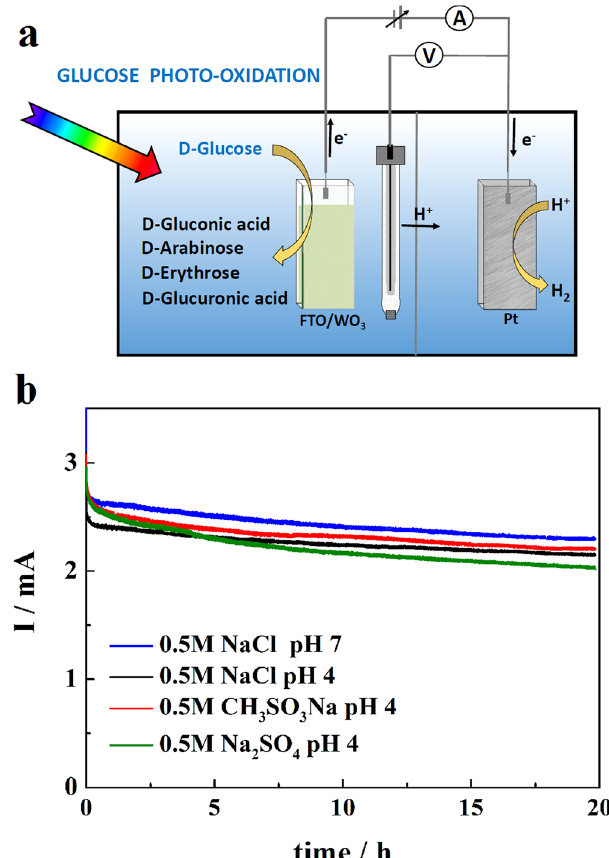
Fig. 4 Photoelectrolysis of glucose. a Schematic of the photoelectrochemical cell used in glucose photo-reforming experiments.